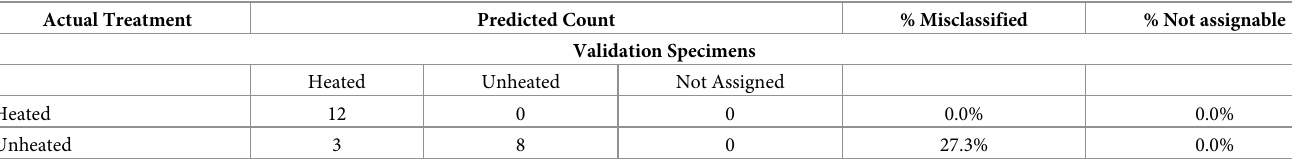
Table 9. Nominal logistic regression model specimen-level prediction results.